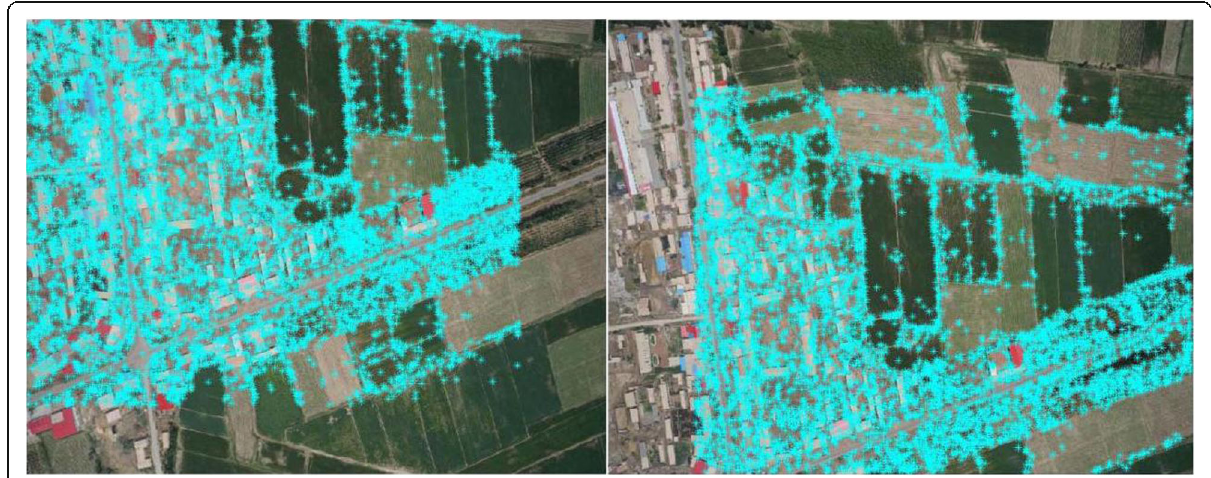
Fig. 3 Feature points extraction using SIFT algorithm and SURF